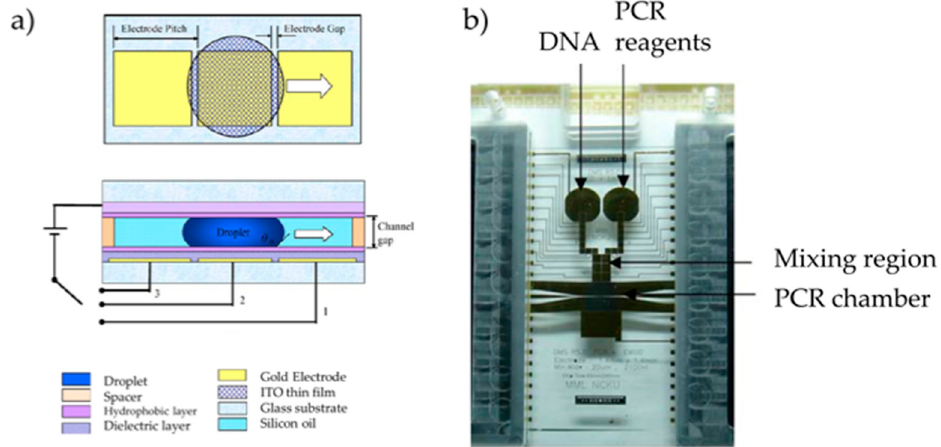
Figure 1. ( a ) Schematic representation of the chip, both in top view and cross-section; ( b ) Photograph of the chip, where the different active regions are visible. Temperature control is based on two platinum heaters, which also provide temperature sensing. Adapted from original in reference [17].